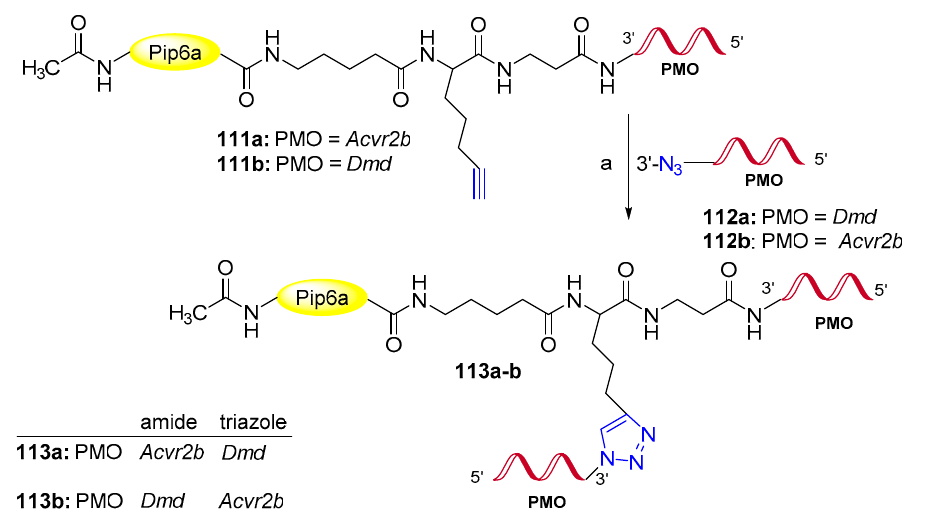
Figure 4. DART-Nrf2 multifunctional oligonucleotide.